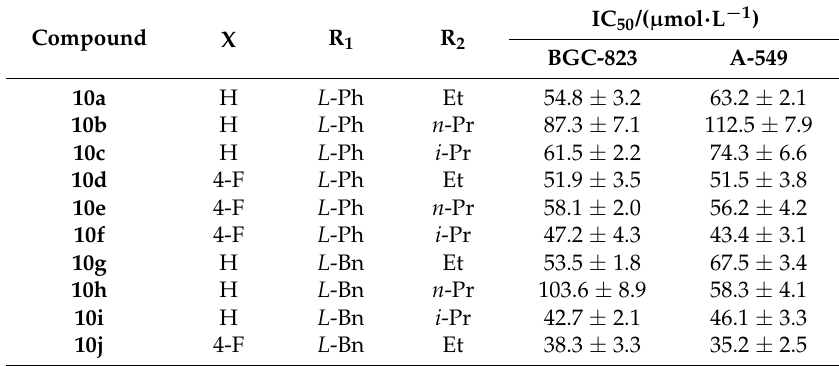
Table 2. IC 50 values of thioureas 10 and 11 for BGC-823 and A-549 cells.